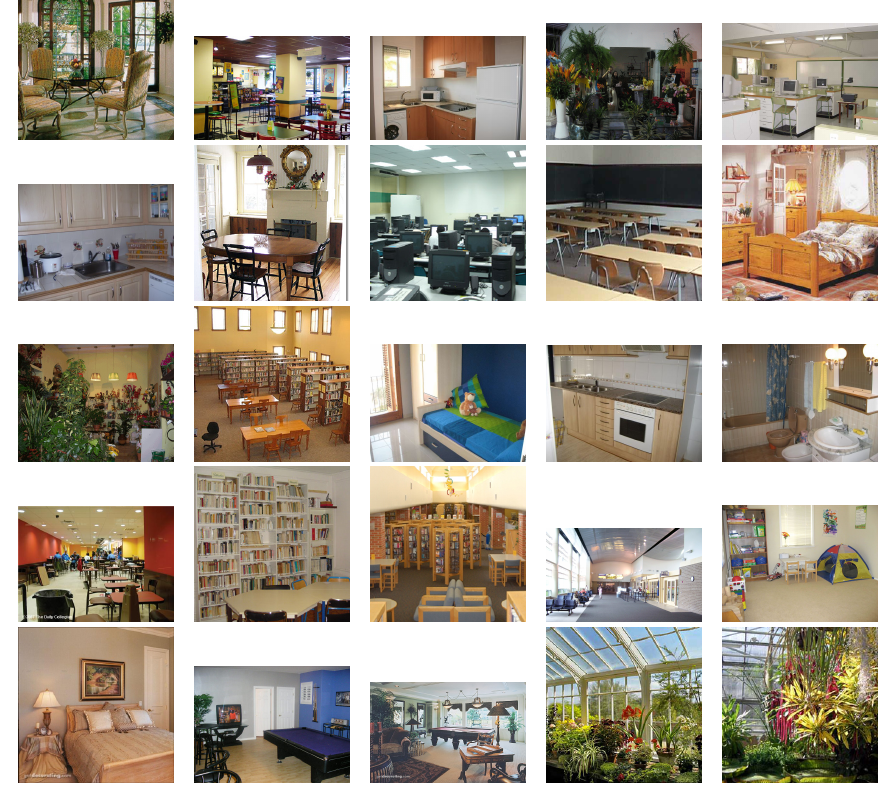
Figure 3. Sample images from the dataset [42] used in the